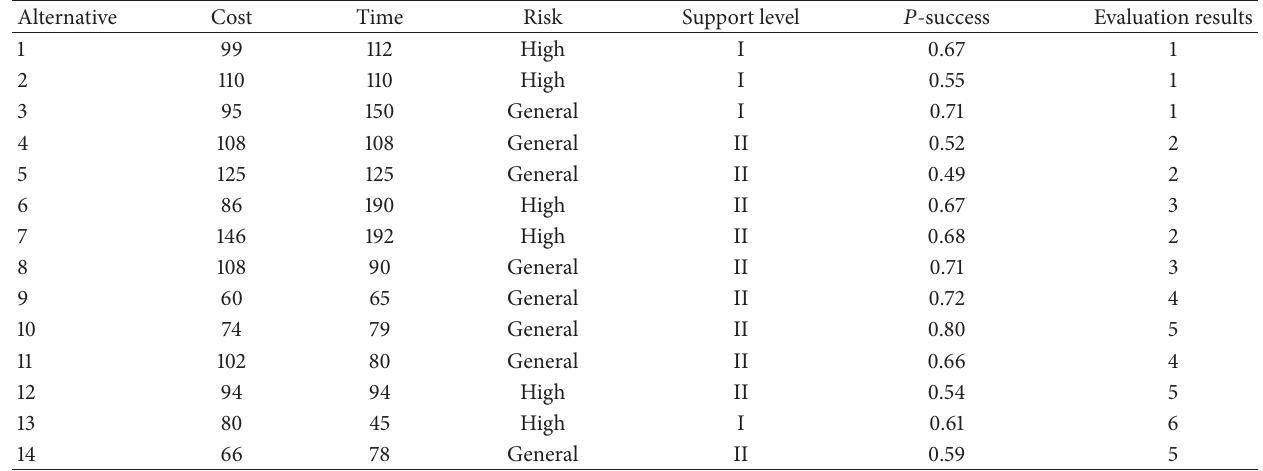
Table 1: The similar cases and corresponding